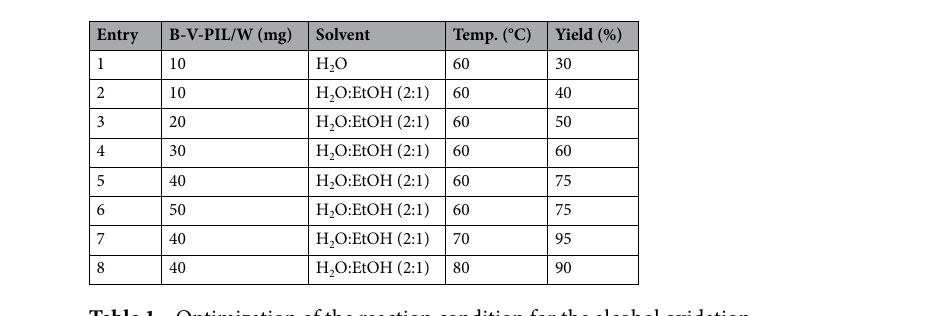
Table 1. Optimization of the reaction condition for the alcohol